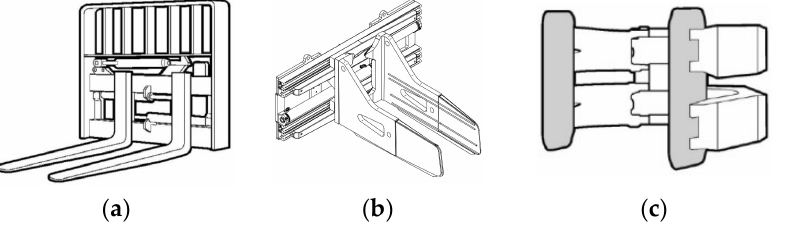
Figure 7. Interchangeable equipment: ( a ) Lateral displacement, ( b ) Clamp with parallel arms, and ( c ) Clamp for reels.